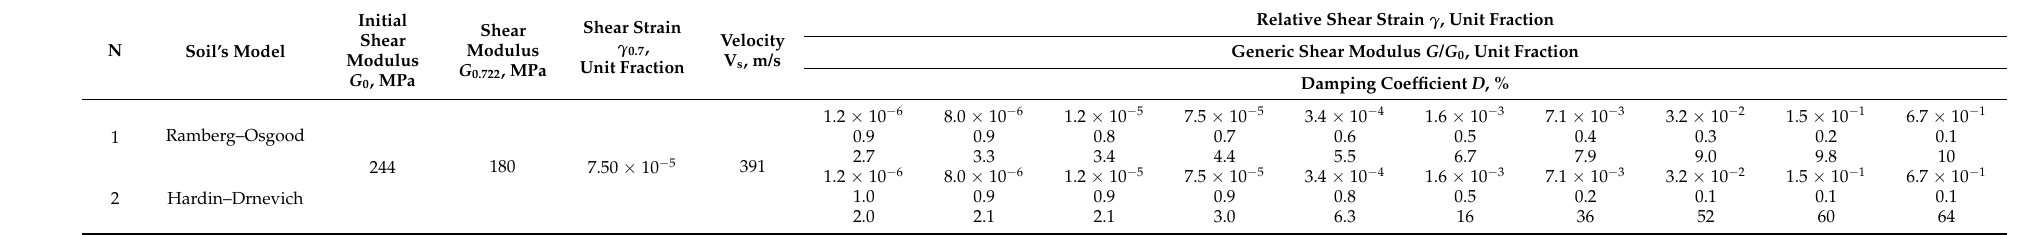
Table 3. Table of recommended values of dynamic